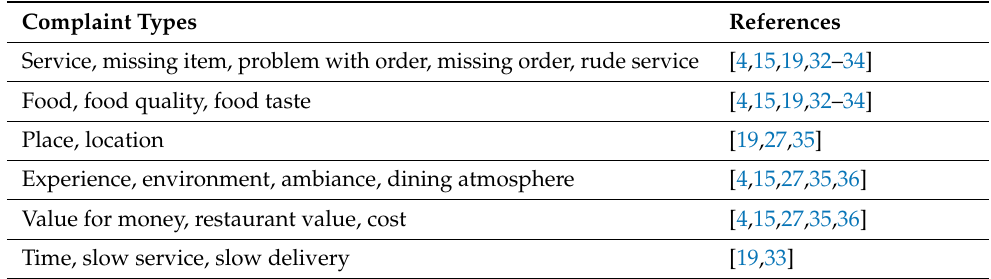
Table 3. Common complaint types in FDS.